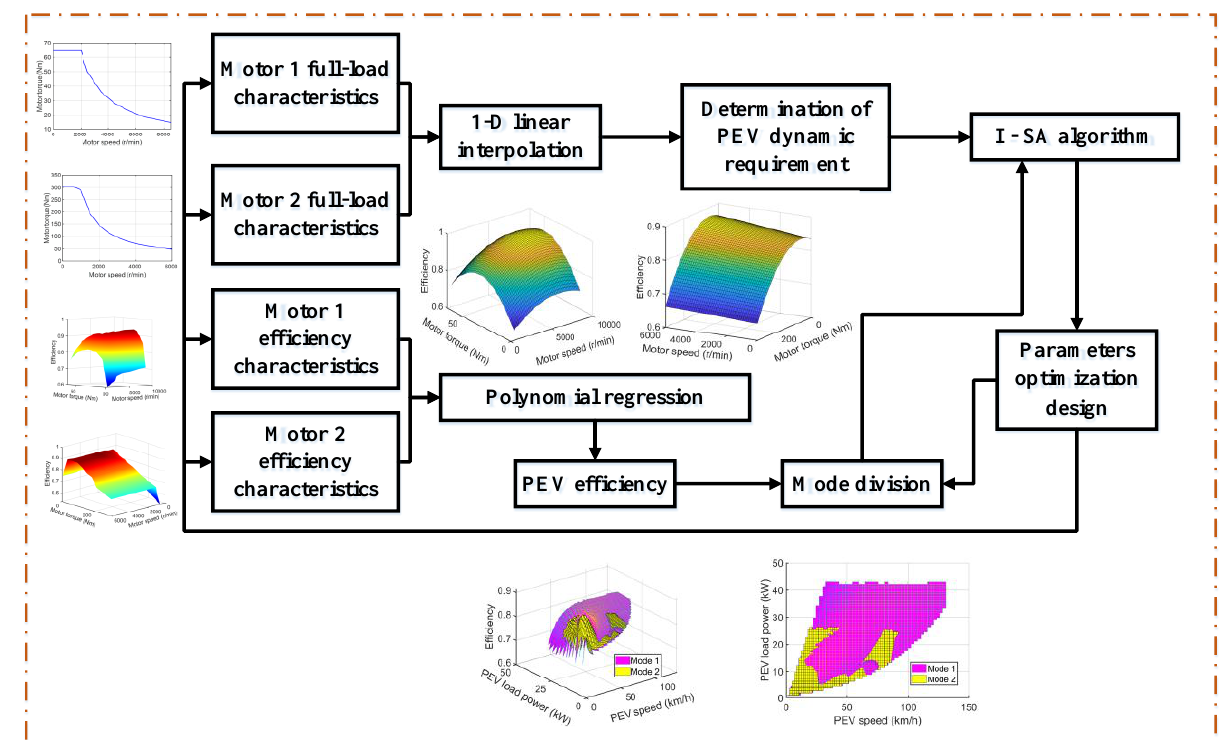
Figure 5. The technical route based on I-SA proposed in this paper.